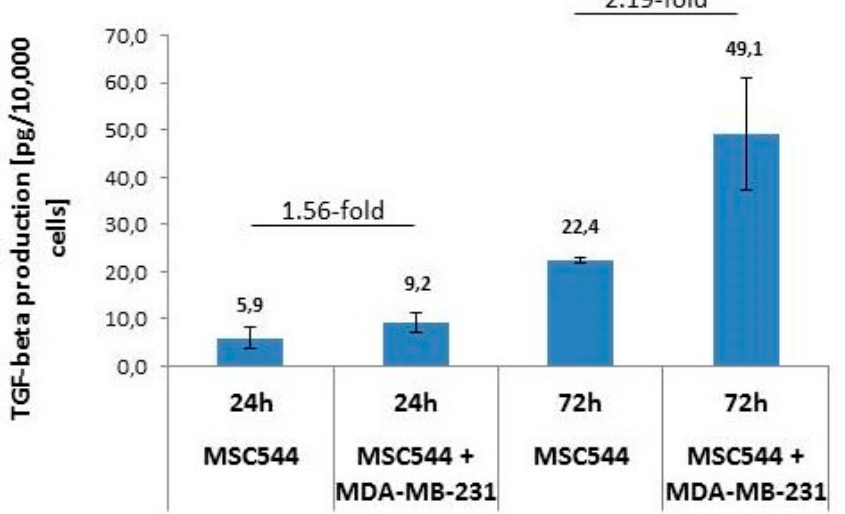
Figure 5. Quantification of secreted bioactive cytokine transforming growth factor- β 1 (TGF- β 1) in MSC544 mono-cultures and co-cultures of MSC544 with MDA-MB-231 cells. Release of active TGF- β 1 from human MSC544 cells (10,000 cells / 24-well) was quantified by TGF- β 1-specific ELISA and compared to TGF- β 1 production of co-cultures between MSC544 and MDA-MB-231 cells (5000 + 5000 cells / 24-well) after 24 and 72 h, respectively. Data represent the mean ± s.d. of three independent experiments.